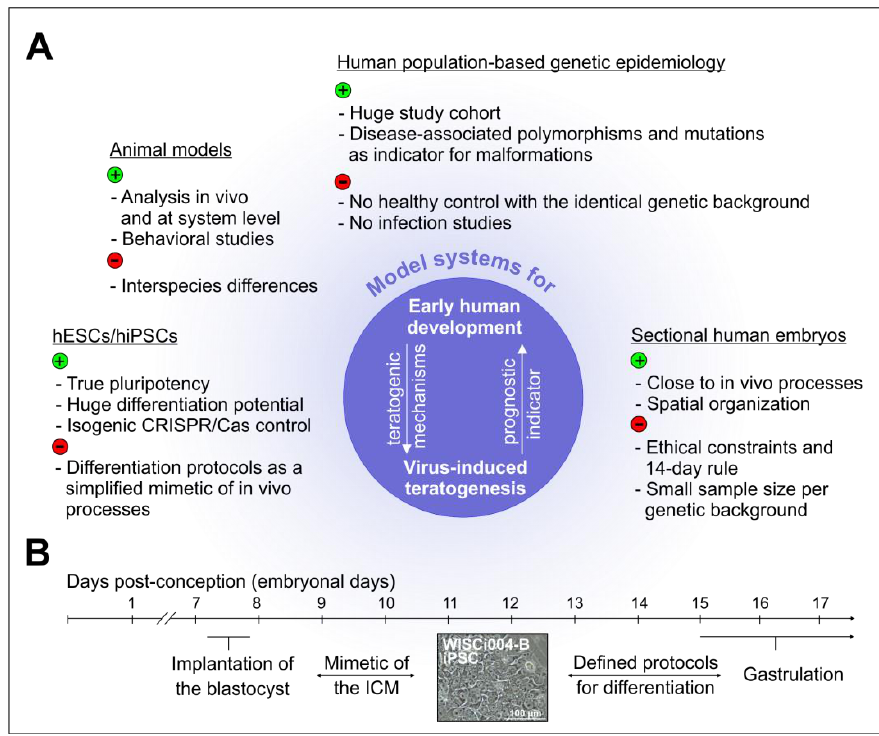
Figure 2. Illustrative summary of current models available for the study of congenital virus infections. ( A ) Contrasting juxtaposition of the respective advantages and disadvantages of in vitro and vivo models for human development. ( B ) Timeline for the very early steps of human embryonal development that are addressable by undifferentiated and differentiating pluripotent stem cells as representatively illustrated by WISCi004-B iPSCs. Timeline is given in embryonal days as compared to gestational age in Figure 1A. As a reference, the reader is referred to the main manuscript text.